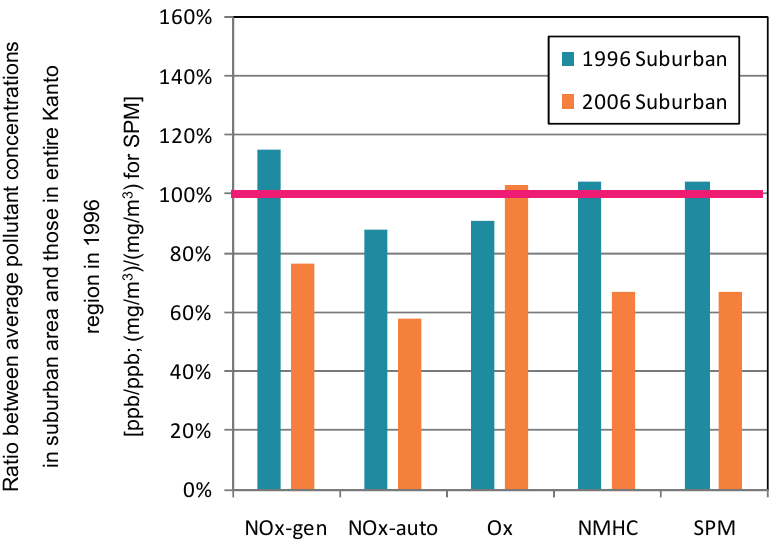
Figure 8. Ratio between average pollutant concentrations in suburban area and those in entire Kanto region during 1996. Average concentration of entire Kanto region in 1996 corresponds to